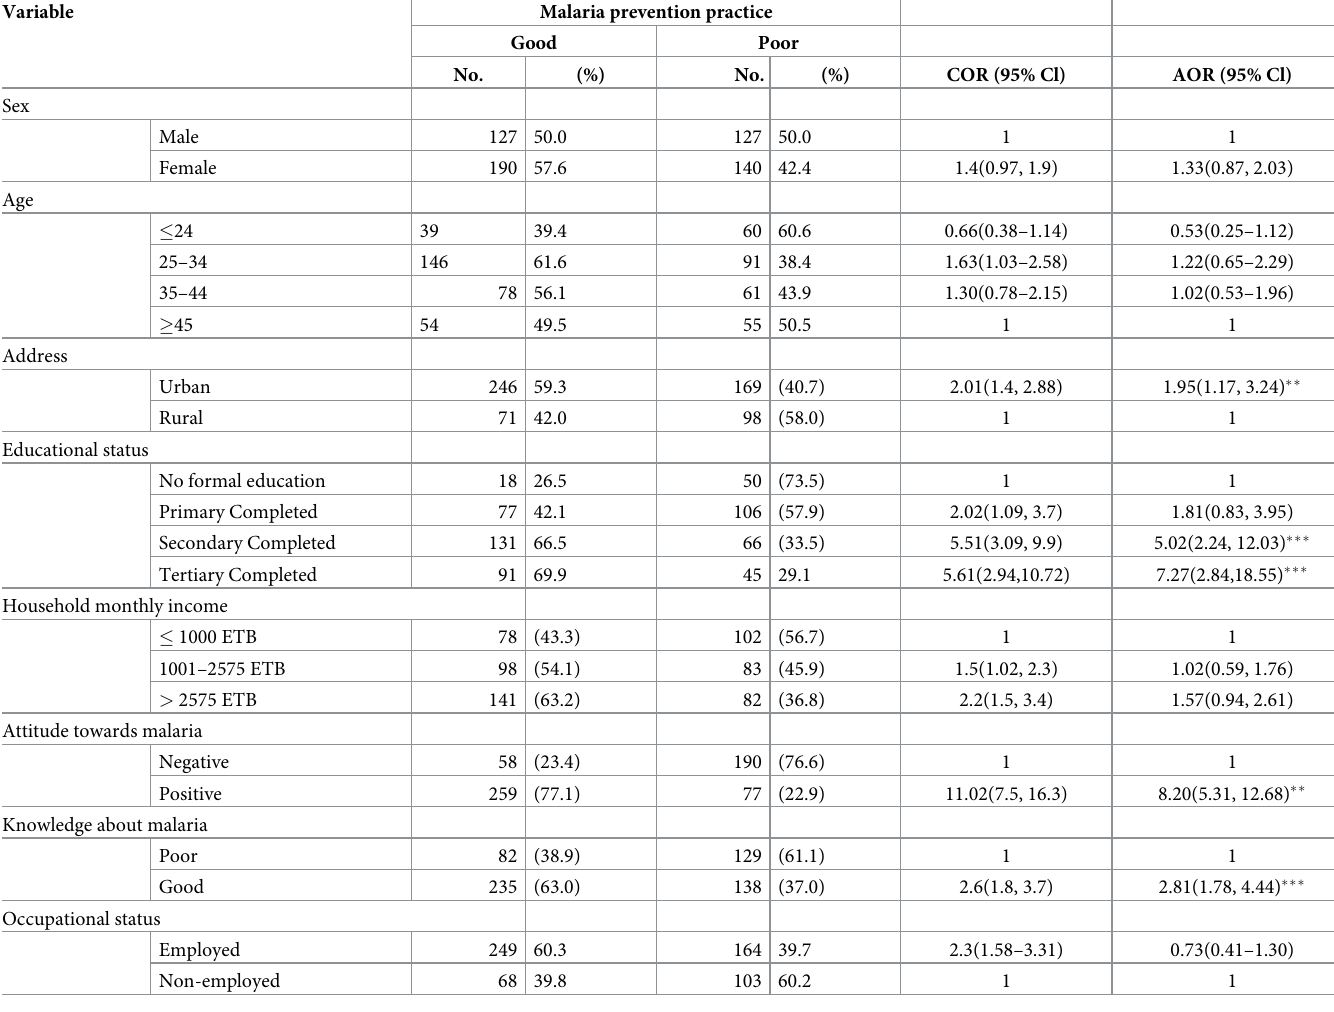
Table 5. Bivariable and multivariable logistic regression analysis for malaria prevention practice and associated factors among households in Hawassa City, South Ethiopia, 2020.